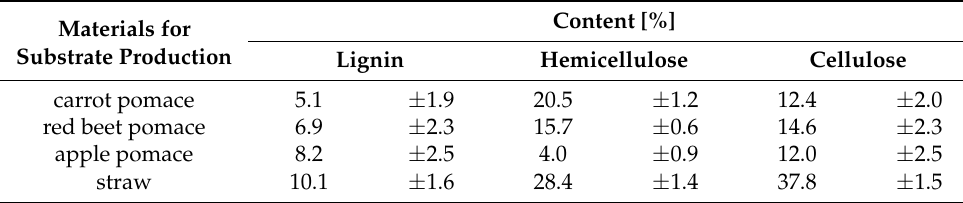
Table 3. Lignin, hemicellulose and cellulose content determined in primary materials used to prepare the substrate. Materials for